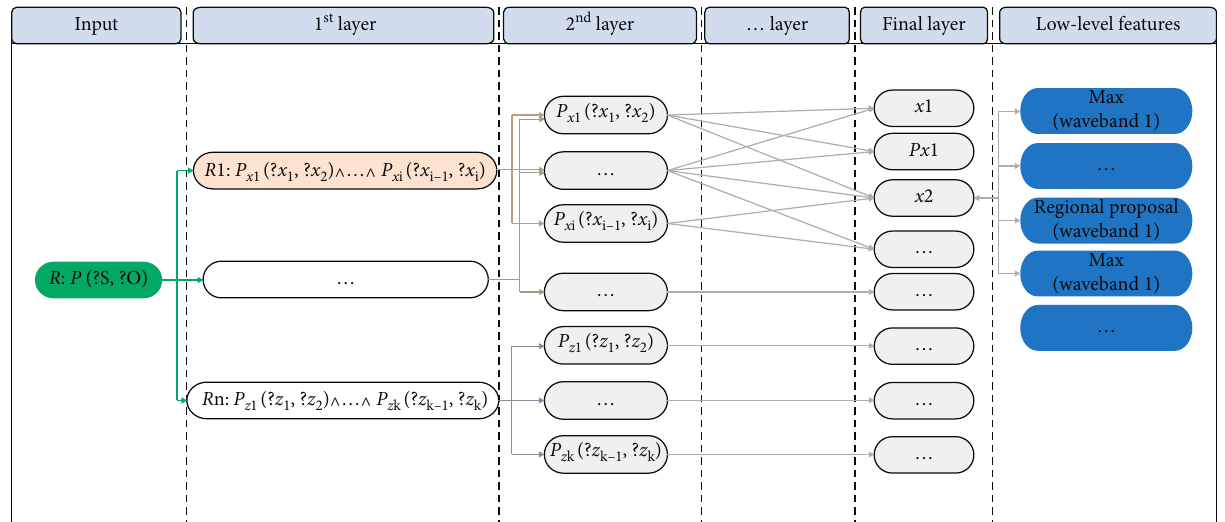
Figure 2: Architecture of SWRL-based